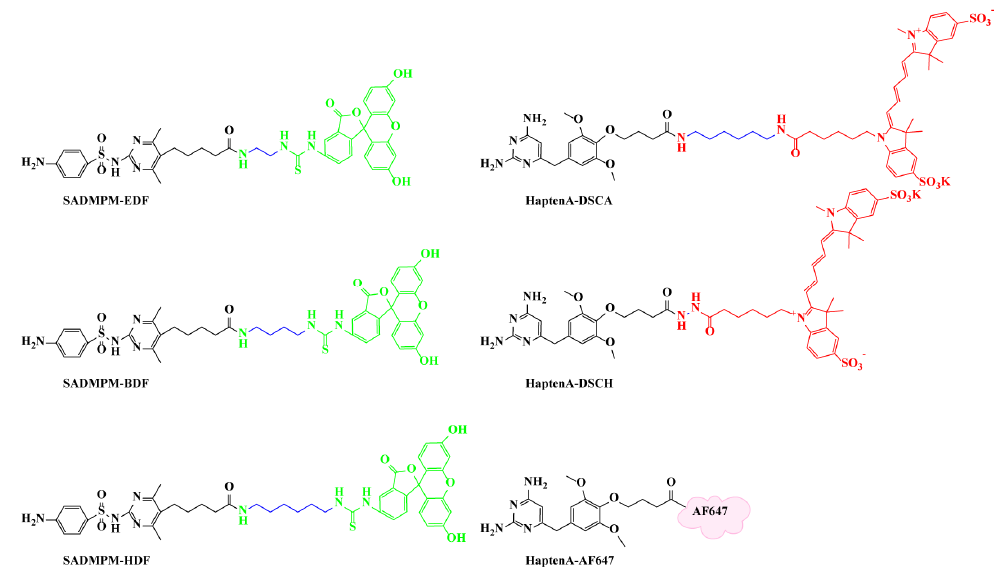
Figure 1. Tracers for SAs and ASGs with varied lengths of the linker are labelled in blue. The structures of short-wavelength tracers for SAs ( left column) and long-wavelength tracers for ASGs ( right